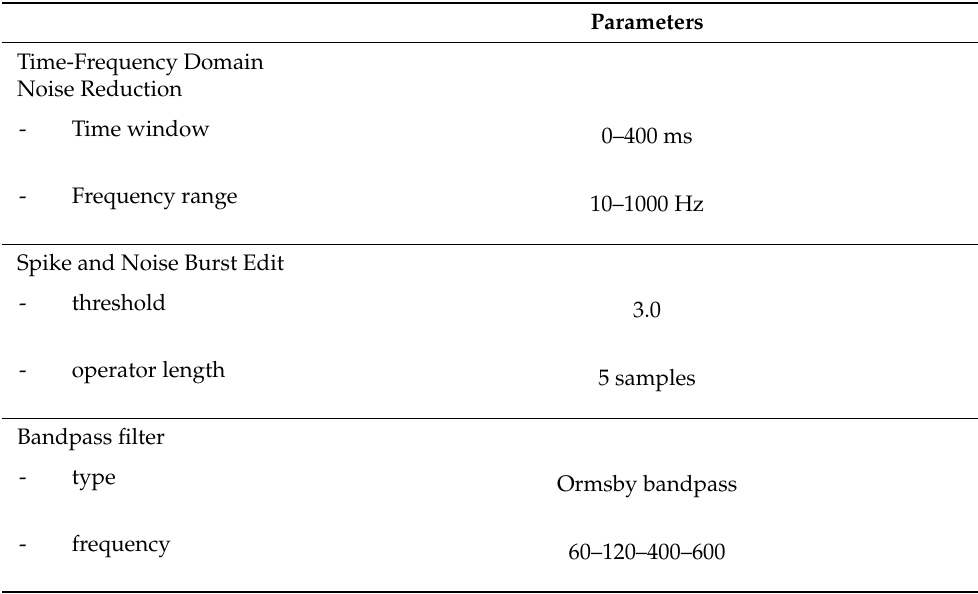
( b ) Figure 6. Results of first break picking: ( a ) manual and ( b ) automatic.